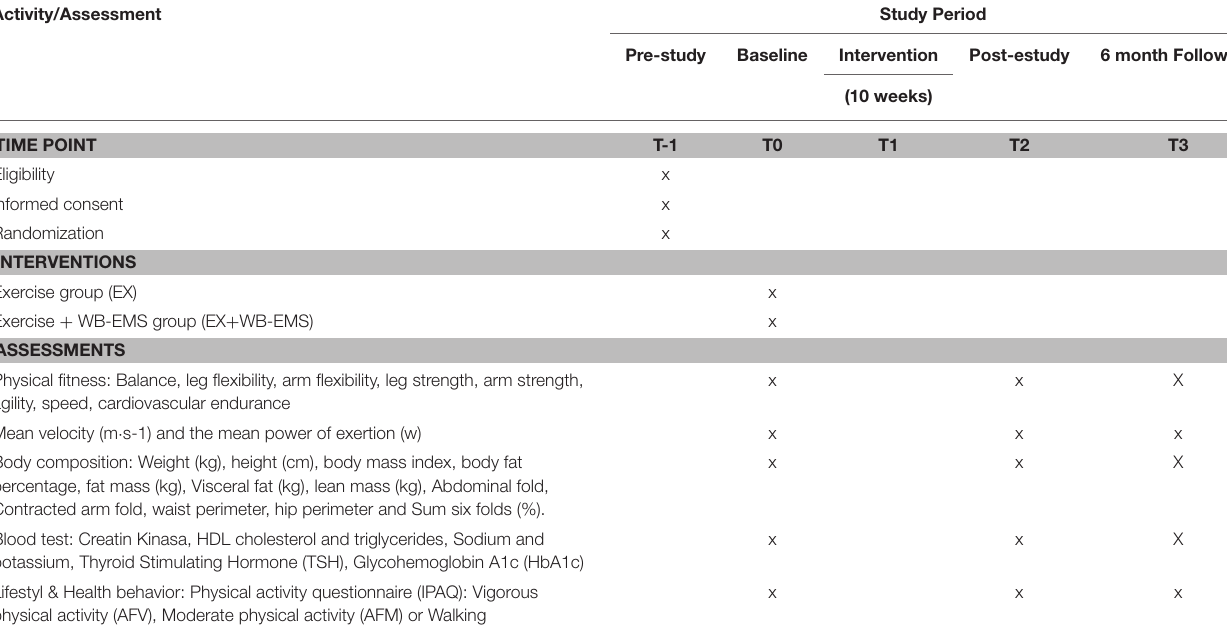
TABLE 1 | Overview of the assessments schedule at baseline and follow-ups. Activity/Assessment Study